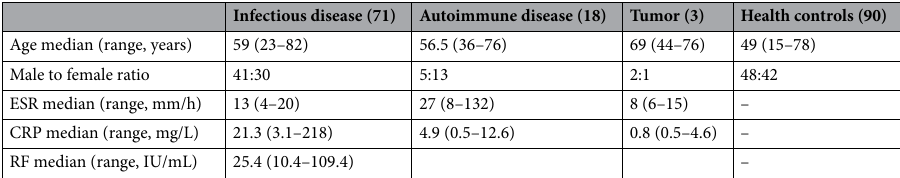
Table 1. Clinical characteristics and laboratory tests in FUO and health